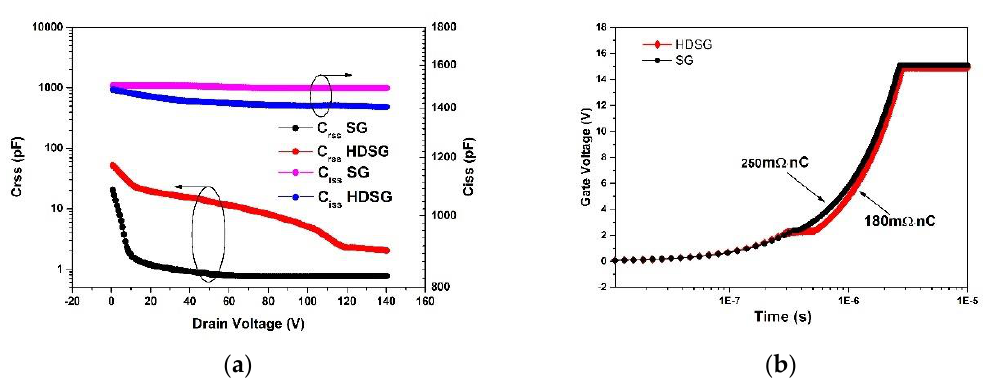
Figure 8. The Crss and Ciss (BV 2 / R SP ) at different drain voltage ( a ) and ( b ) comparison of gate charge and R SP × Q gd for HDSGRSO and SGRSO UMOSFETs.